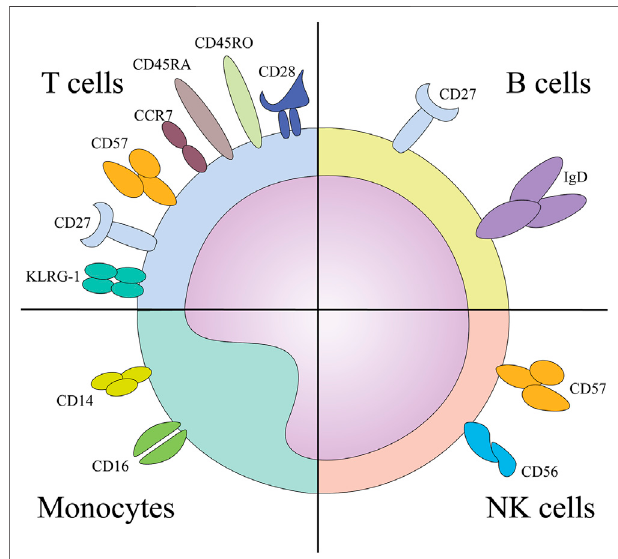
FIGURE 2 | The surface markers implicated in the immunosenescence phenotype of designated cells. Abbreviations: KLRG-1, Killer cell lectin like receptor sub family G member 1; NK, natural killer